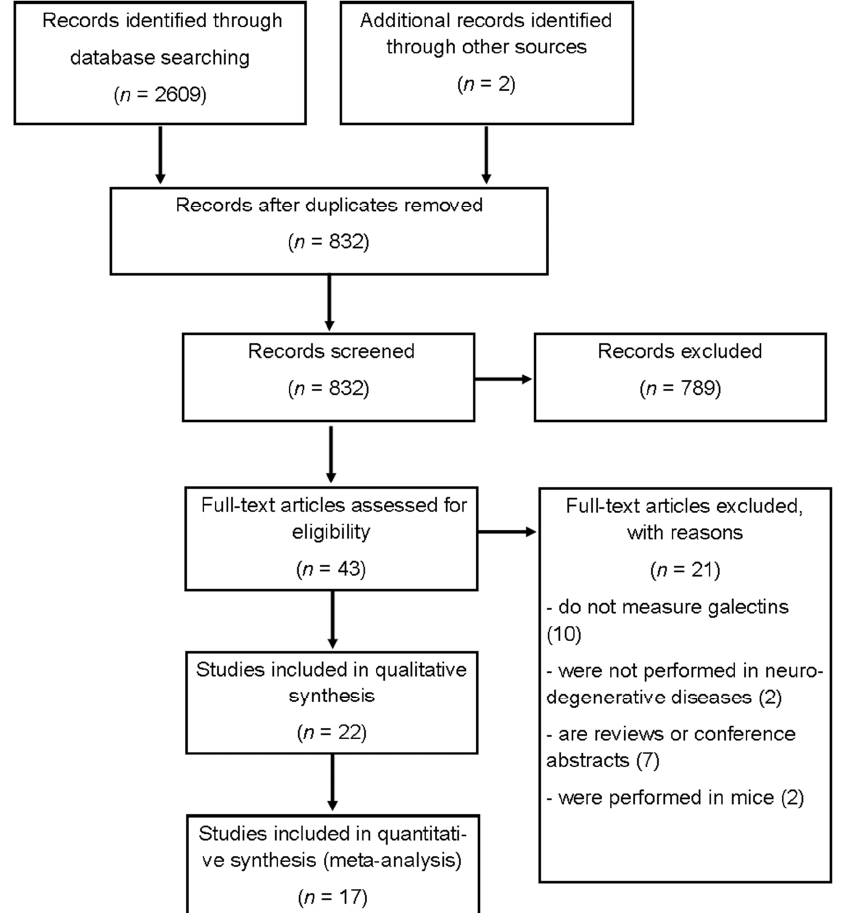
Figure 1. Flow diagram of the publication search and selection process.